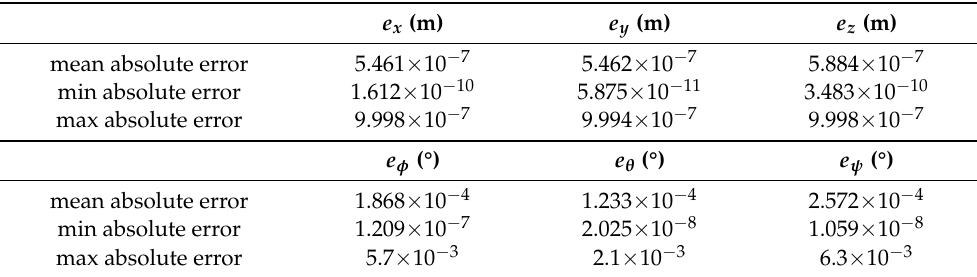
Table 8. Error indicators for optimized solutions.